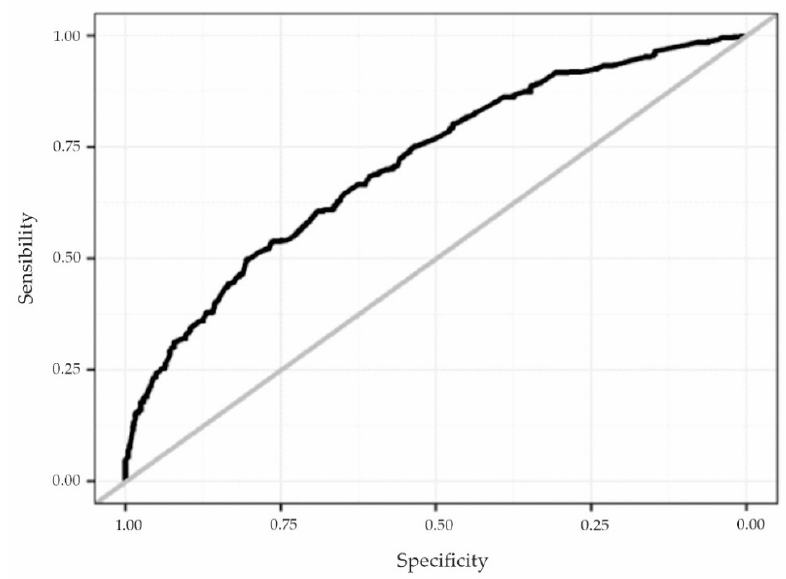
Figure 2. ROC curve of the multivariate logistic regression model used. Source: own elaboration.